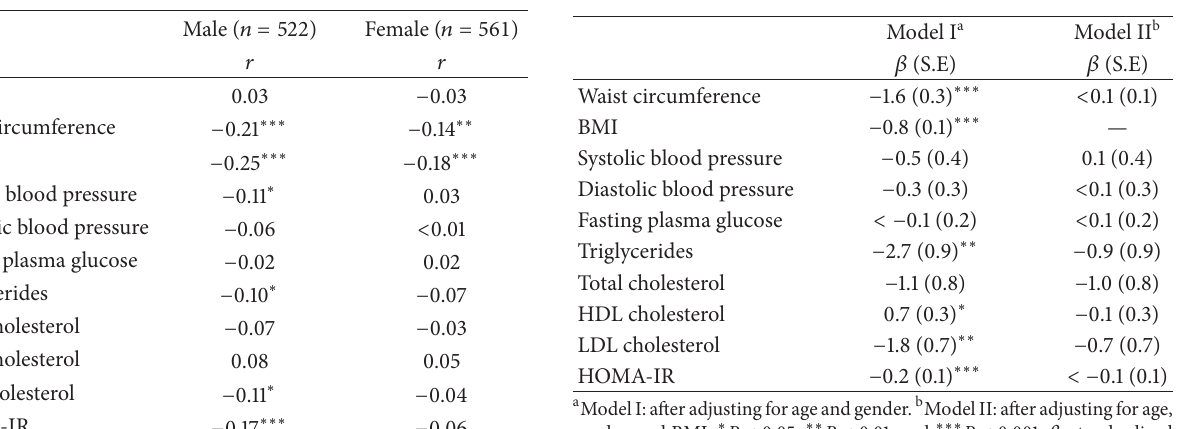
Table 4: Linear regression of cardiometabolic variables associated with sRAGE in both